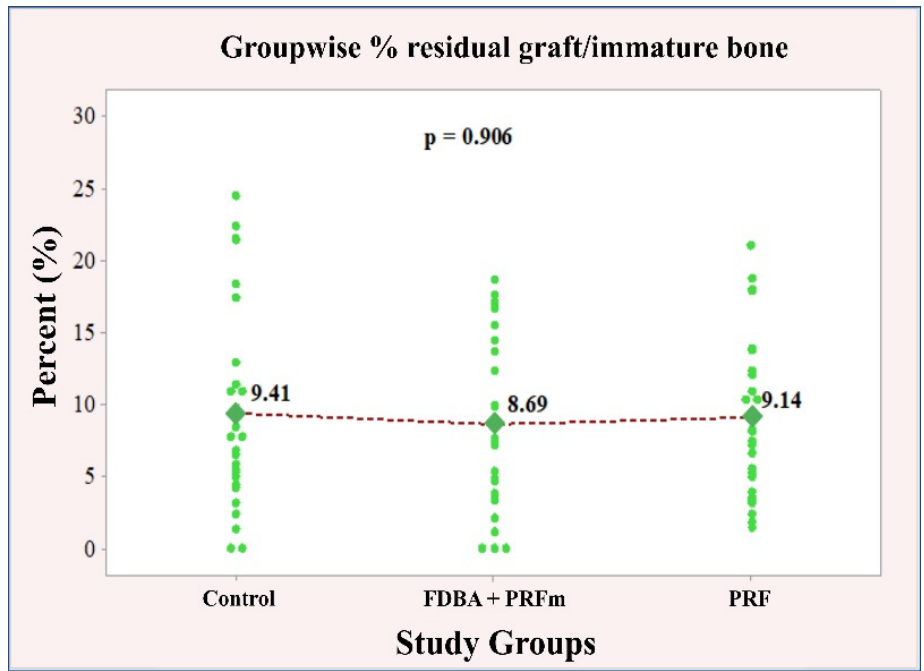
Figure 10 . Individual and mean values of % residual graft/immature